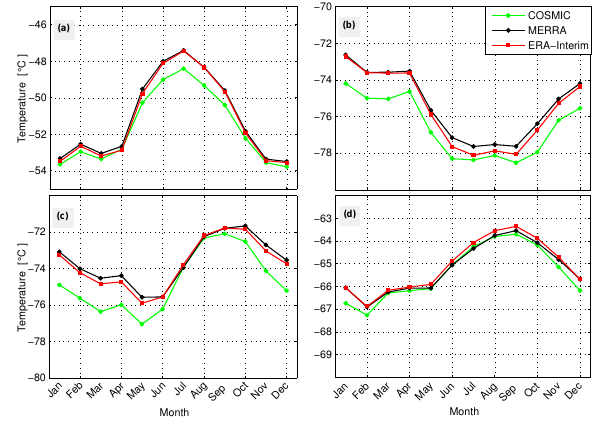
Figure 5. Seasonal cycle of temperature ( ◦ C) at (a) 200hPa, (b) 100hPa, (c) 70hPa, and (d) 50hPa from August 2006 to De- cember 2013 based on COSMIC RO, MERRA, and ERA-Interim averaged over the GBM river basin.